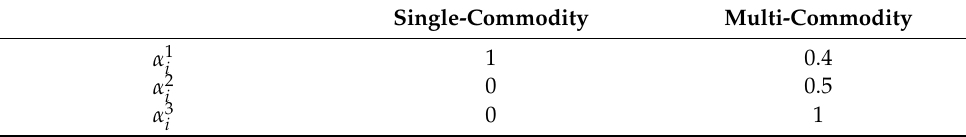
Table 1. Examples of α i , s a in for single-commodity and multi-commodity